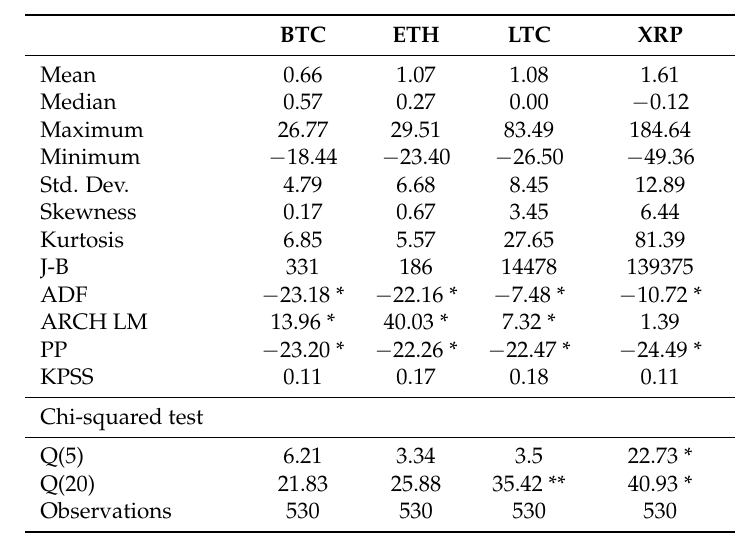
Table 2. Summary statistics of daily returns related to four top